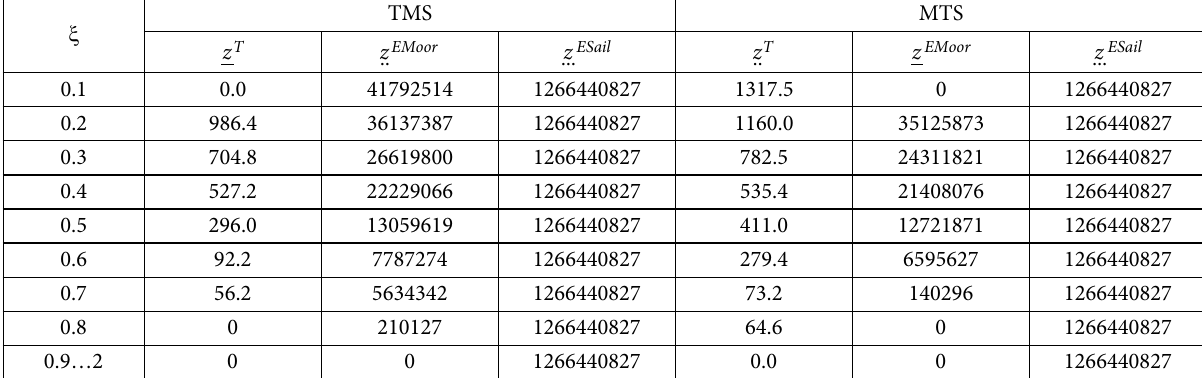
Table 6. The objectives affected